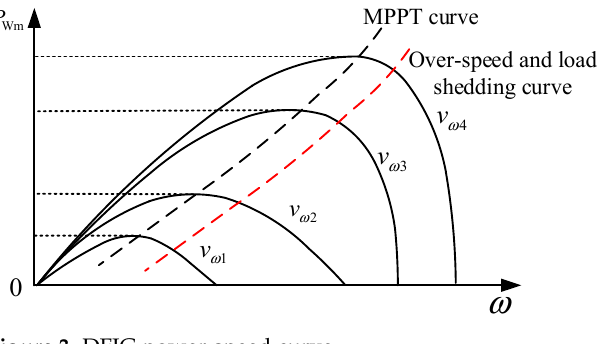
Figure 3. DFIG power-speed curve.